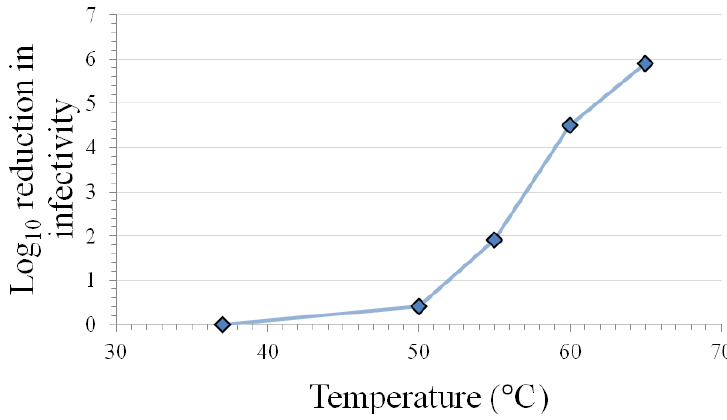
Table 1. Readers interested in additional information on this topic are referred to certain of the references [8–10,12,18–20,22,30,31]. Figure 1. Inactivation of feline calicivirus strain F9 infectivity by 2 min heating at various